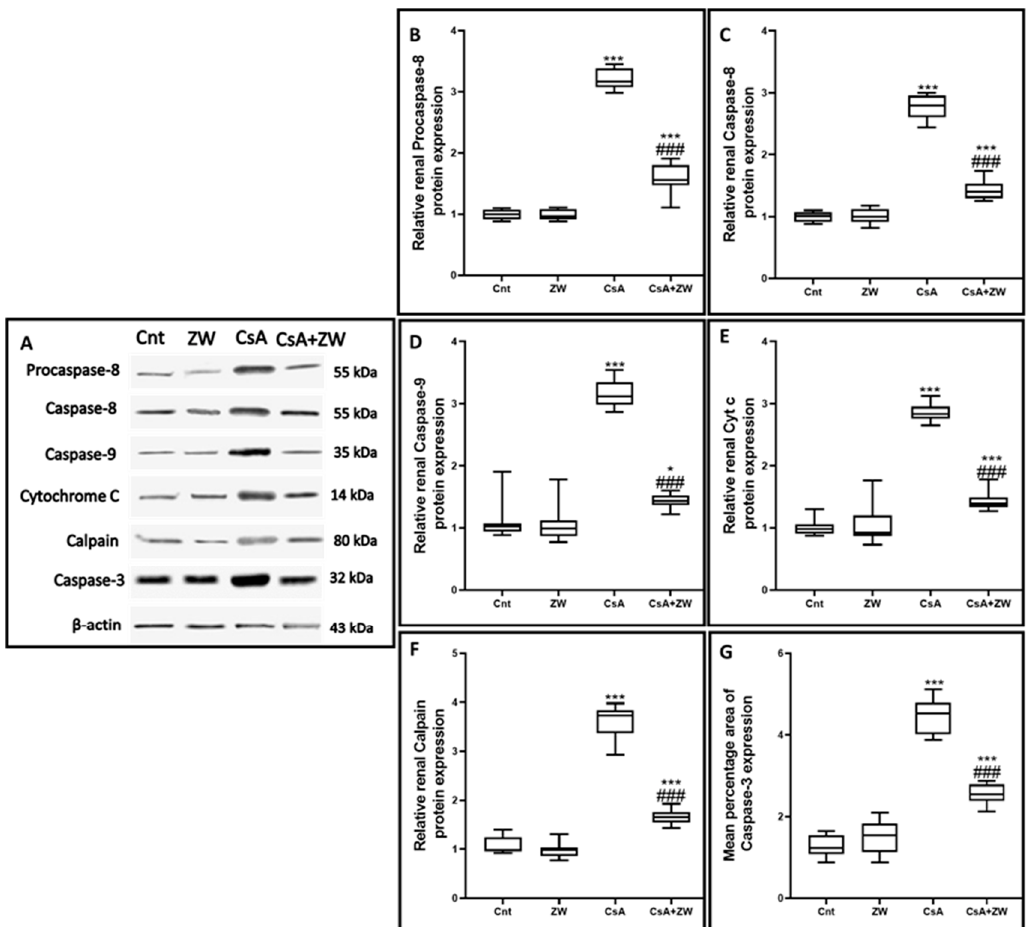
Figure 5. The e ff ect of ZW on the expression of the proteins (A,B) procaspase-8, (A,C) caspase-8, (A,D) capase-9, (A,E) Figure 5. The effect of ZW on the expression of the proteins ( A , B ) procaspase-8, ( A , C ) caspase-8, cytochrome C, (A,F) calpain, and (A,G) caspase-3 according to Western blo tt ing assay. *** p < 0.001, and * p < 0.05 vs. control ; ( A , D ) capase-9, ( A , E ) cytochrome C, ( A , F ) calpain, and ( A , G ) caspase-3 according to Western blotting ### p < 0.001 vs. CsA. assay. *** p < 0.001, and * p < 0.05 vs. control ; ### p < 0.001 vs.